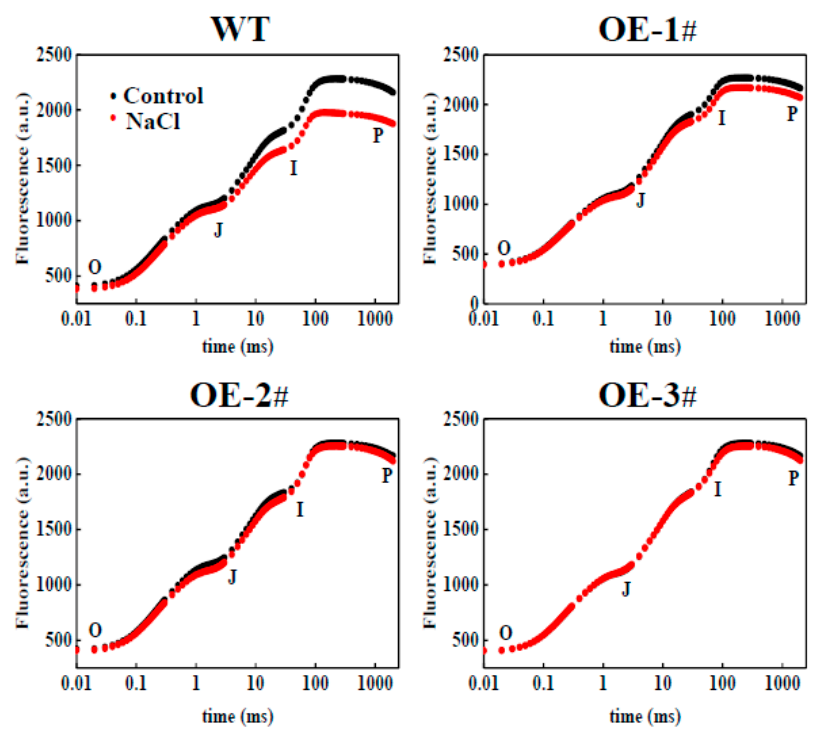
Figure 7. Change in Chl a fluorescence transient curves (OJIP) (log time scale) in leaves of WT and CsTGase OE plants under salt stress.